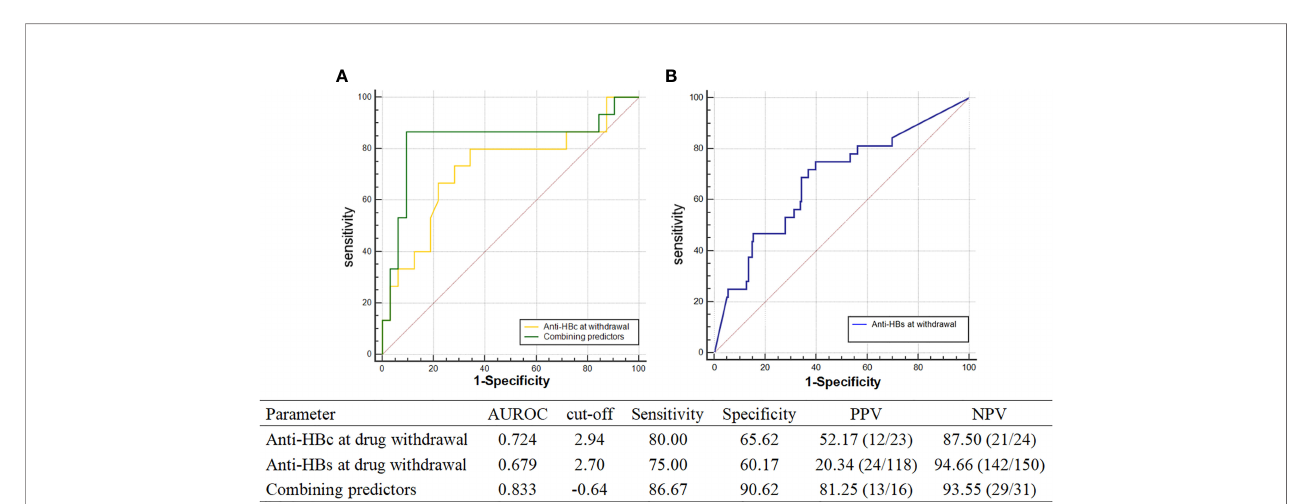
FIGURE 3 | AUROC of recurrence predictors. (A) AUROC of anti-HBc at drug withdrawal and combining predictors; (B) AUROC of anti-HBs at drug